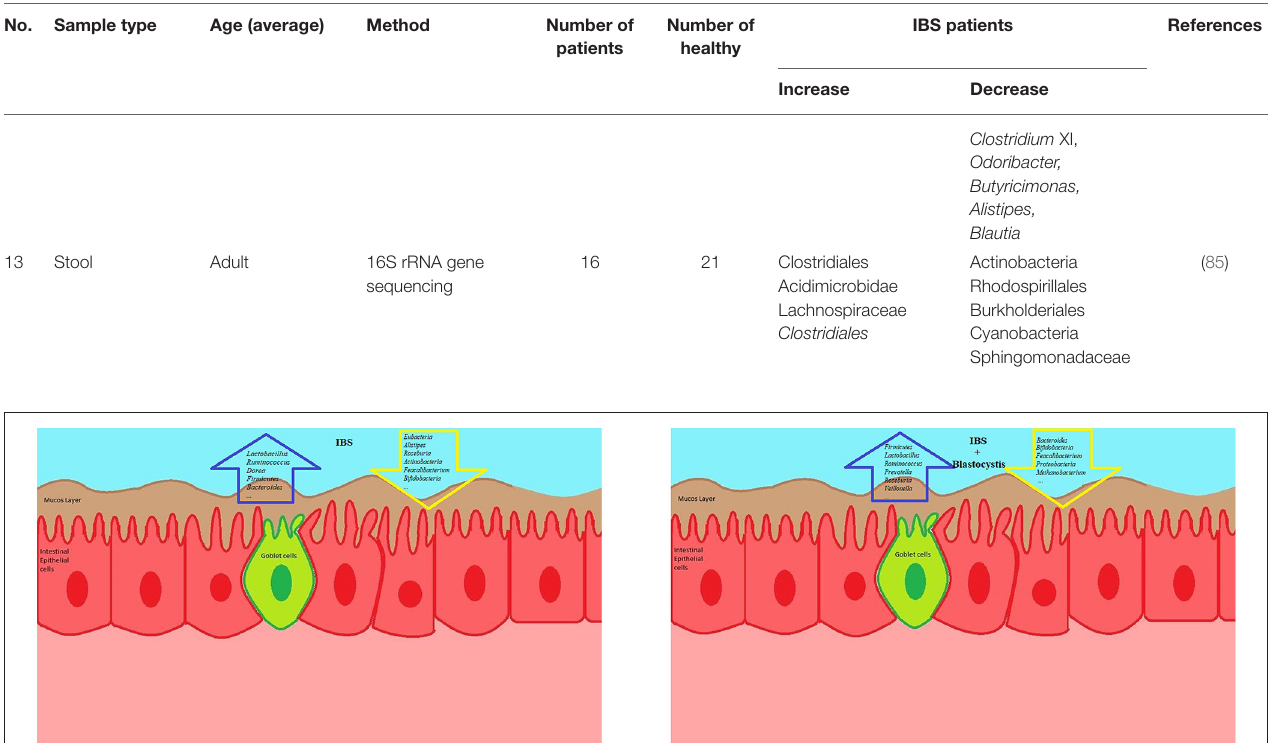
FIGURE 1 | The schematic view presenting a correlation between Blastocystis sp. and certain microbiota signatures. The presence of Blastocystis sp. has not been linked with specific signature of gut microbiota. Although this protist seems to a healthy indicator for the gut microbiota, Blastocystis sp. can reduce a Firmicutes / Bacteroidetes ratio and protective bacteria. In addition, the low and high presence of Blastocystis sp. in IBD and IBS, respectively, might be related to the differences in the gut microbiota composition between IBD and IBS.